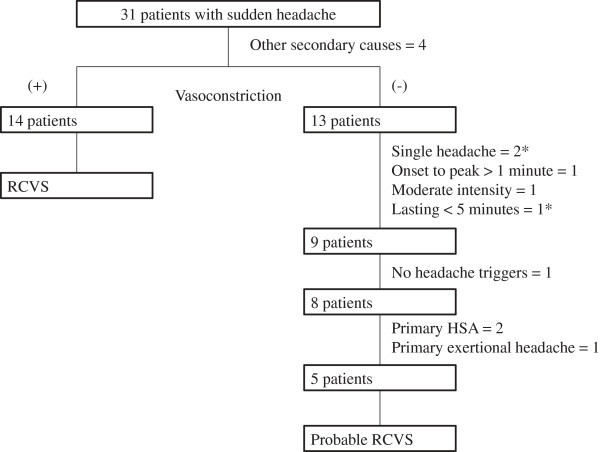
Test of the ICHD-3 criteria (beta version) in patients with sudden headache. *One patient had single headache lasting < 5 minutes. Moderate headache intensity refers to 4-6 on a 0-10 numerical rating scale. ICHD: International Classification of Headache Disorders; RCVS: reversible cerebral vasoconstriction syndrome; HSA: headache associated with sexual activity.